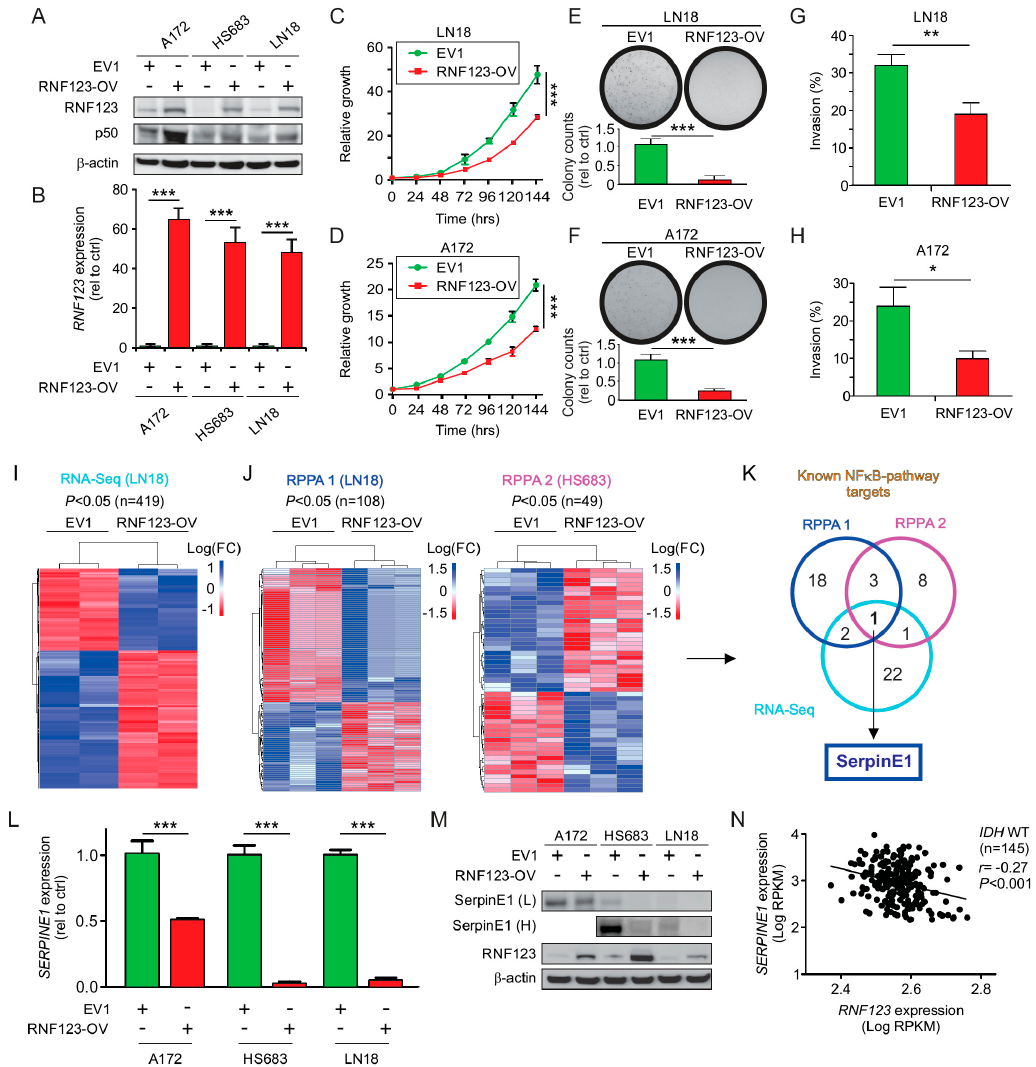
Figure 2. Analysis of cell proliferation and invasion in GB cells with RNF123-OV. ( A ) A172, HS683, and LN18 cell lines were stably transfected with empty vector (EV1) or a cDNA encoding Myc- RNF123 (RNF123-OV). RNF123-OV and p50 were assessed by Western blot, and β -actin was used